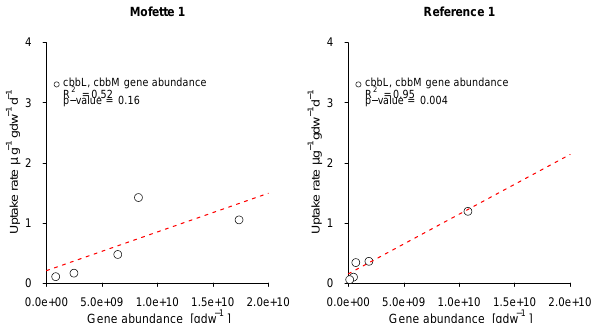
Figure 4. Correlation of marker genes encoding for RubisCO and measured uptake rates in mofette soil 1 and reference soil 1 in the soil depth profile from 0 to 40cm depth. The good correlation in the reference soil indicates high contribution of autotrophic microor- ganisms to measured uptake rates. In the mofette soil R 2 is consid- erable lower, most probably, because also other CO 2 fixation cycles than the CBB cycle, like the acetyl–CoA cycle, are important path- ways in these